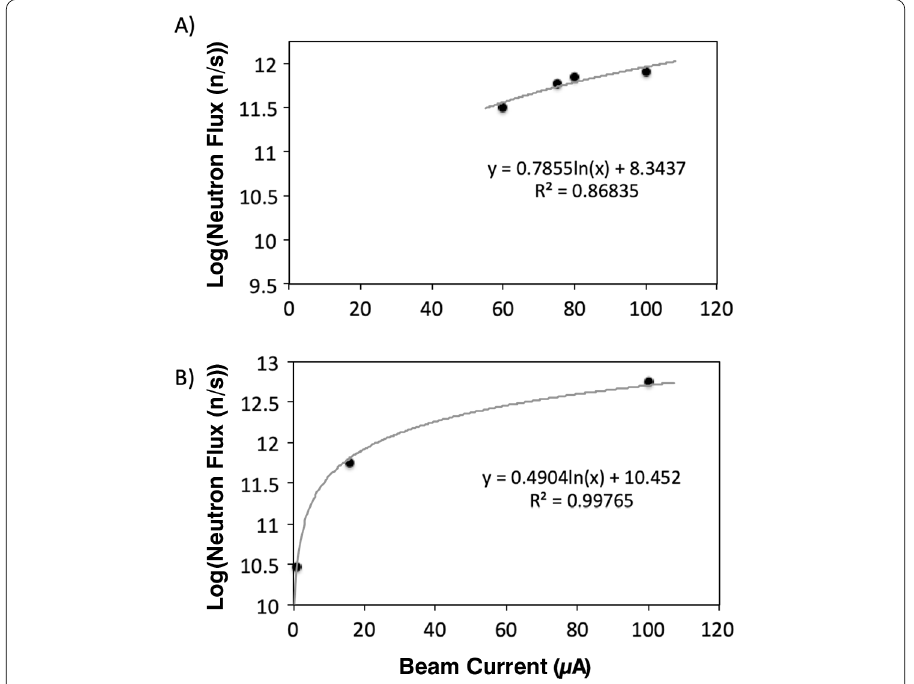
Figure 2 Reported neutron fluxes arising from the 18 O ( p , n ) 18 F transmutation reaction as a function of proton beam current for ( A ) 16.5 MeV and ( B ) 18.5 MeV energy cyclotrons [7, 12, 13,